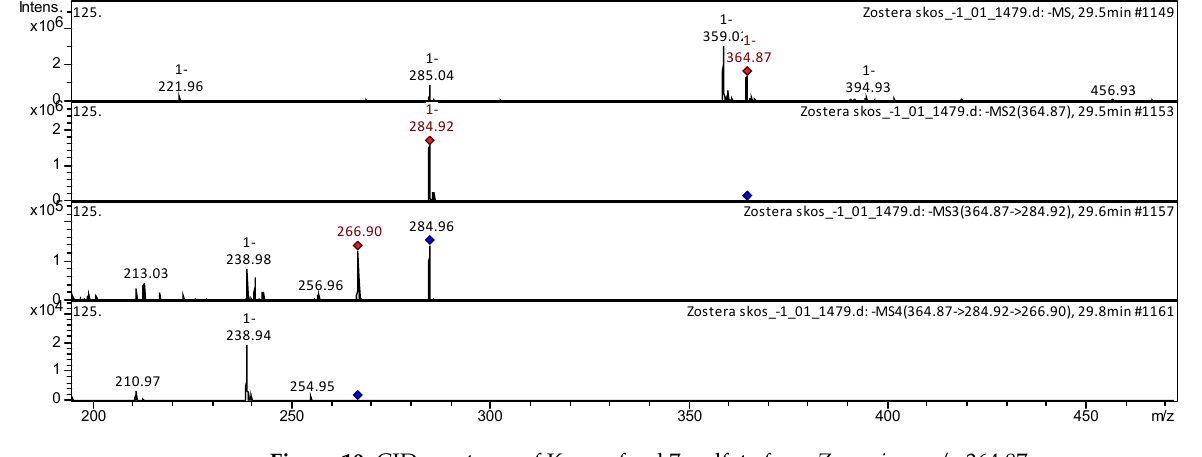
Figure 10. CID spectrum of Kaempferol 7–sulfate from Z. marina , m / z 364.87.